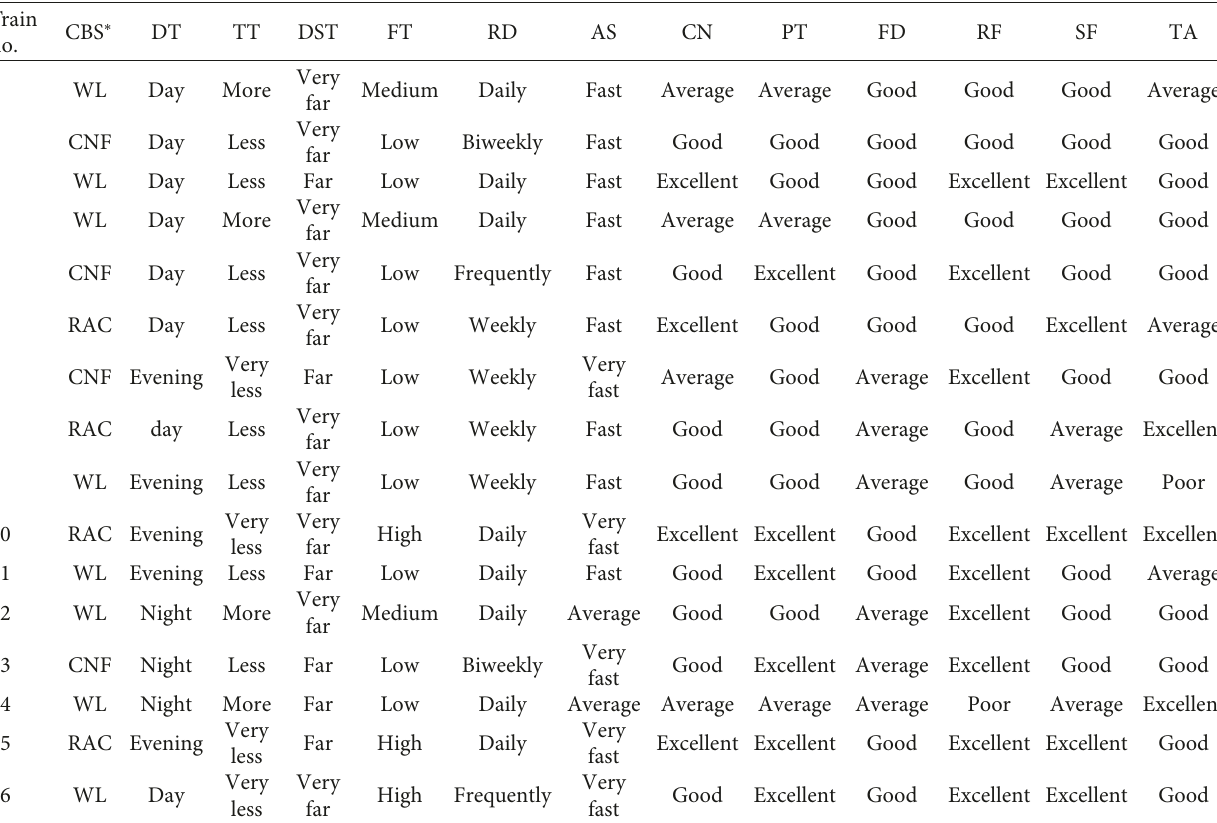
Table 3: Information table after discussions with an expert of the